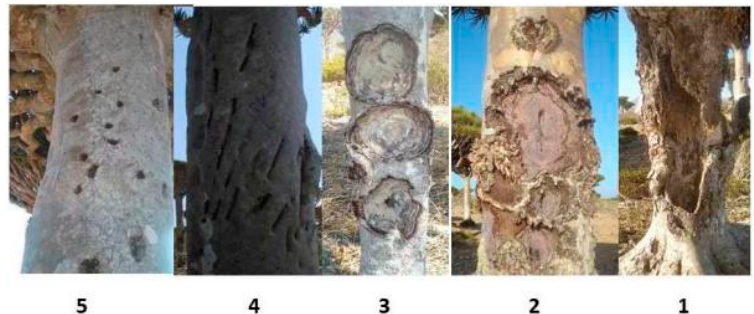
Figure 3. Trunk status categories (own classification). ( 5 ): trunk without wounds or with a few small wounds of 2–3 cm diameter or one medium wound of 3–10 cm diameter; ( 4 ): trunk with several small wounds or a few medium wounds but the trunk is still strong; ( 3 ): trunk with large wounds of 10–40 cm diameter and greater, with the center of the trunk still alive; ( 2 ): trunk with large wounds, the center of the wounds mostly dead and sometimes hollow, the wounds sometimes linked together; ( 1 ): trunk with large hollow wounds.